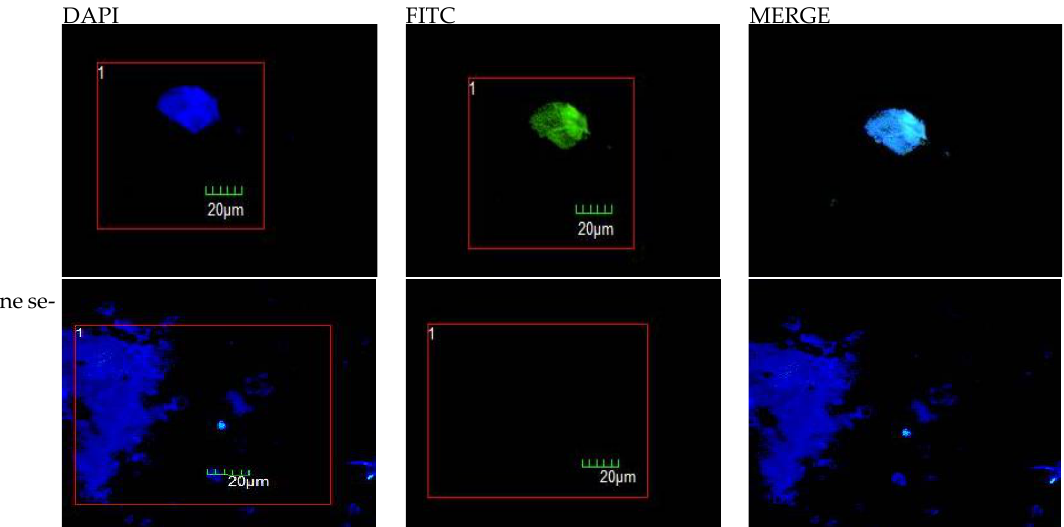
Figure 1. Amplification products by quantitative PCR of macrophages transfected with the plasmid at 24 h. Lane 1: negative control, Lane 2: positive control (pVAX-rOmpB-24 plasmid), Lane 3: non-transfected macrophages. Lanes 4 and 5: Macrophages 12 h after transfection with pVax (4) or OmpB-24 (5), Lanes 6 and 7: Macrophages 24 h after transfection with pVax (6) or OmpB-24 (7), Lanes 8 and 9: Macrophages 48 h after transfection with pVax (8) or OmpB-24 (9), Lanes 10 and 11: Macrophages 72 h after transfection with pVax (10) or OmpB-24 (11). Transfection efficiency was assessed by indirect immunofluorescence (IFI) using a previously generated mouse antiserum against full-length recombinant OmpB-24 and a FITC-labeled anti-mouse secondary antibody. Viable transfected cells were identified by confocal microscopy using DAPI counterstaining and observing at least 5 different fields. The mean number of viable transfected cells was 90.86% vs. 0% for non-transfected cells (Figure 2), which was corroborated by fluorescence-activated cell sorting (FACS) using indirect staining against OmpB-24. (Data not shown).